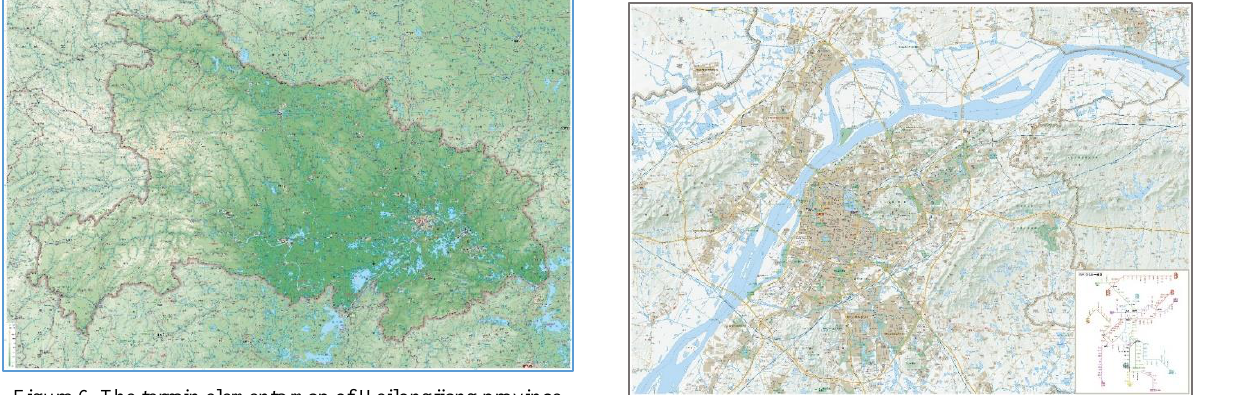
Figure 6. The terrain elements map of Heilongjiang province